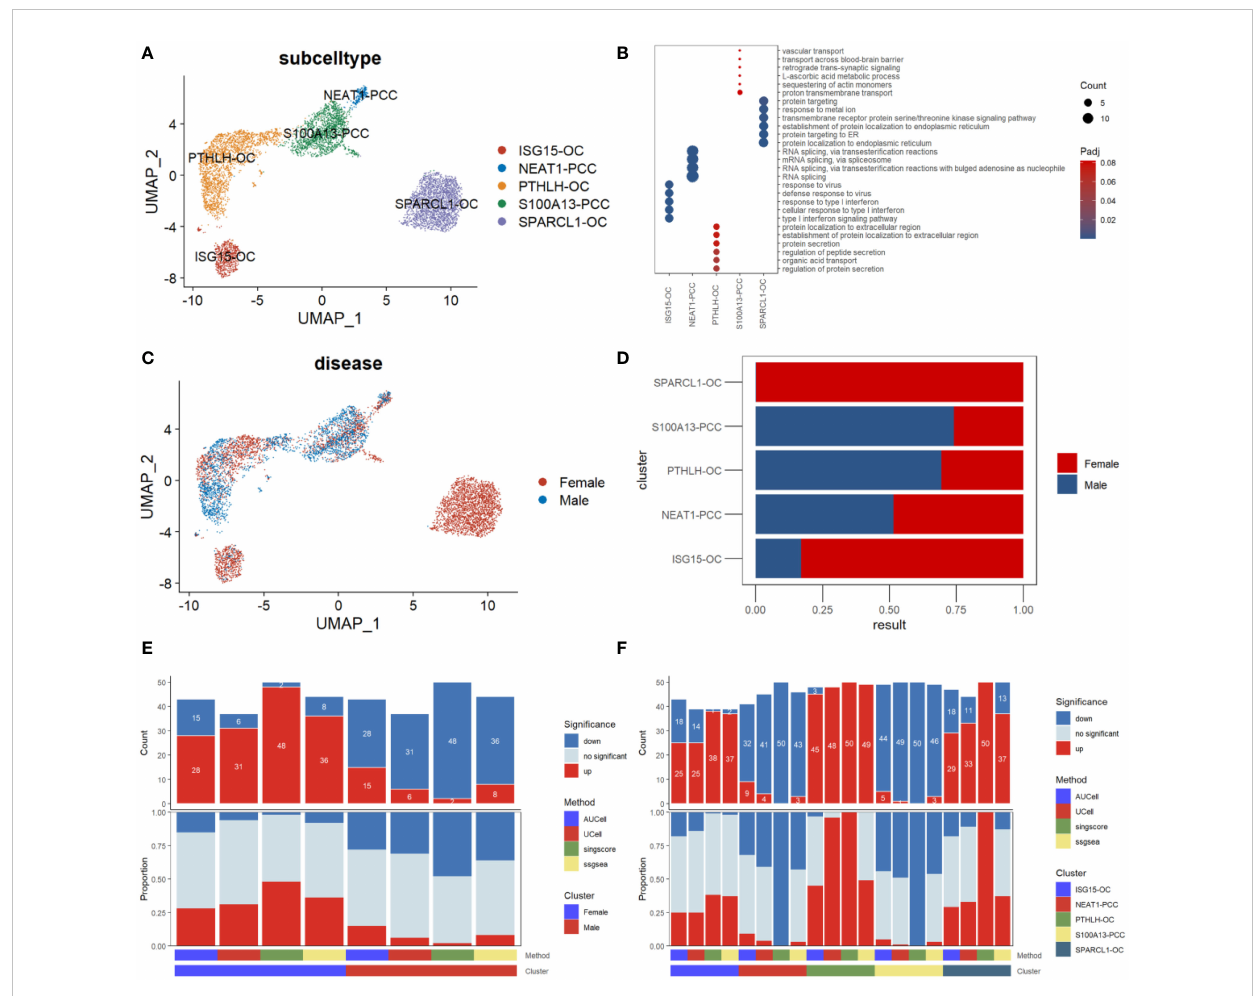
FIGURE 4 Subpopulation analysis of parathyroid cells. (A) Umap visualization of parathyroid subpopulation (B) Dot plot of representative cell markers of each cell subtype. (C) Umap visualization of cells derived from male and female patients. (D) Cell subpopulation proportion comparison between male and female patients. (E) Bar plot of the count and proportion of signi fi cant regulation pathways based on four different algorithms by sex. (F) Bar plot of the count and proportion of signi fi cant regulation pathways based on four different algorithms by cell